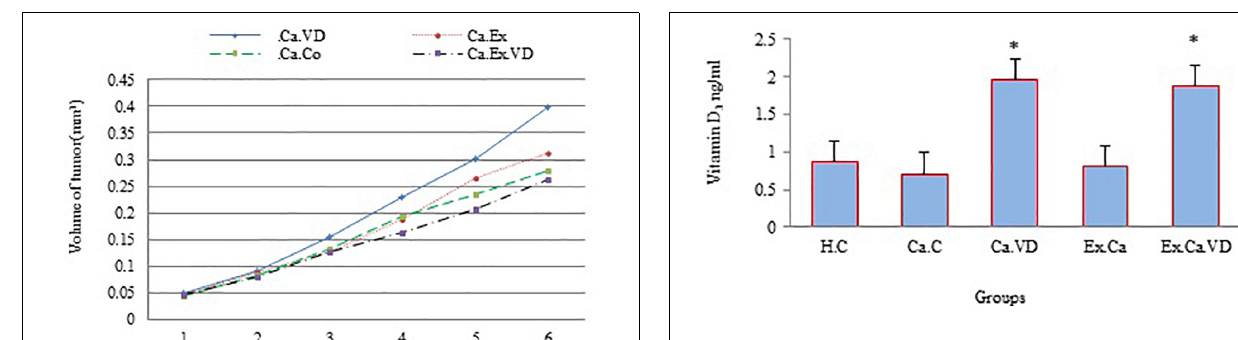
FIGURE 4 | The levels of vitamin D during 6 weeks of interval exercise training (IET) and vitamin D supplementation treatment in all experimental groups. H.C, healthy control group; Ca.C, cancer control group; Ca.VD, cancer with injection of vitamin D group; Ca.Ex, cancer exercise training group; Ca.Ex.VD, cancer exercise training with injection of vitamin D group. Data are presented as mean ± SD. ∗ Significant level ( P ≤ 0.05).